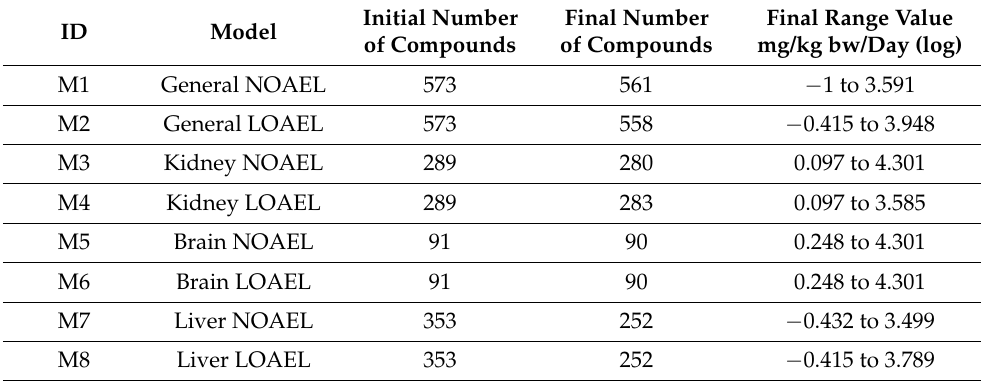
Table 3. Datasets